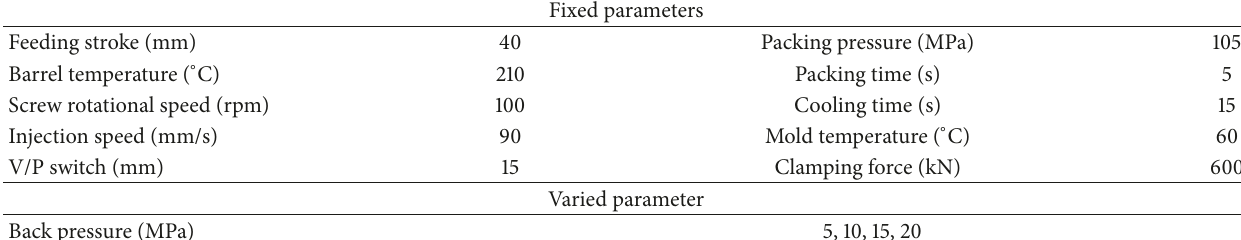
Table 8: Process parameter settings for varied back pressure experiments.